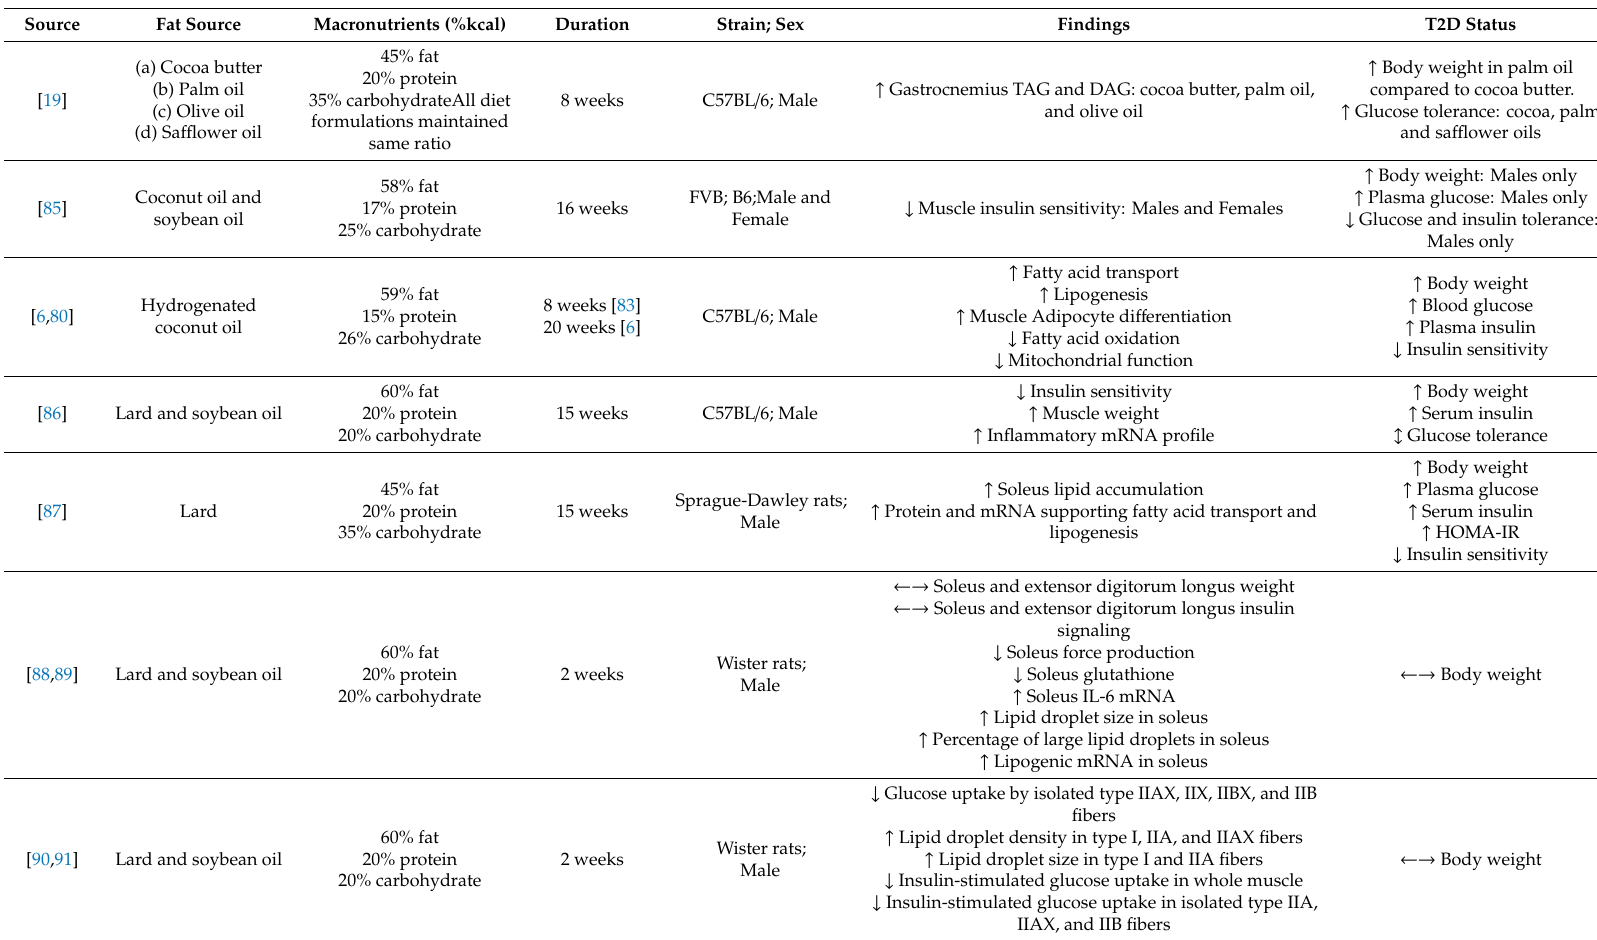
Table 5. Skeletal